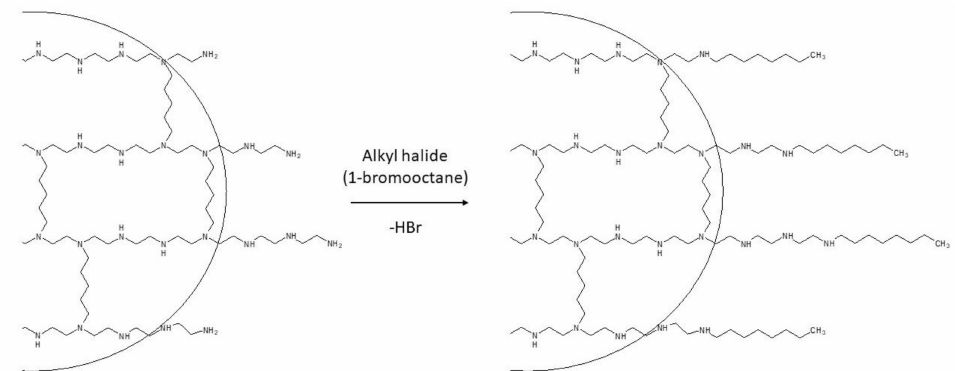
Figure 3. Telomerization in the N-alkylation method with the use of 1-bromooctane. Adapted from [60].